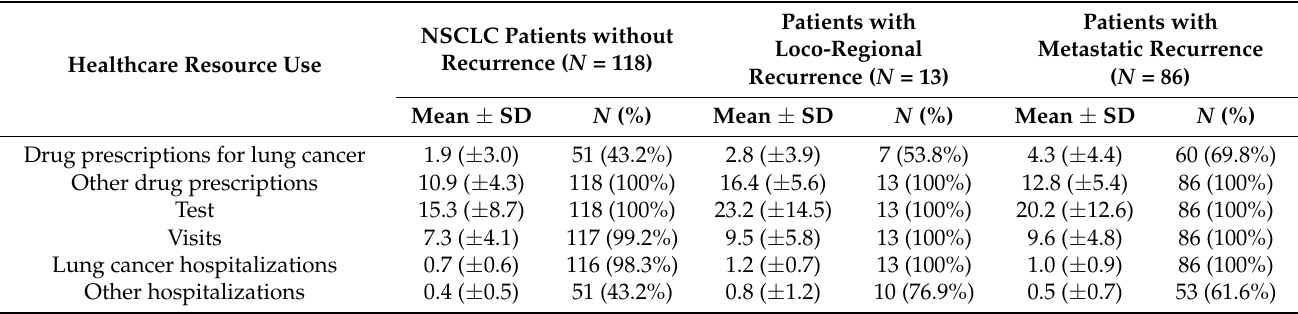
Table 5. Annualized healthcare resource use during the first 2 years after surgery among alive eNSCLC patients who were treated with chemotherapy after surgery in stage II–IIIA (inclusion period January 2015–June 2019).